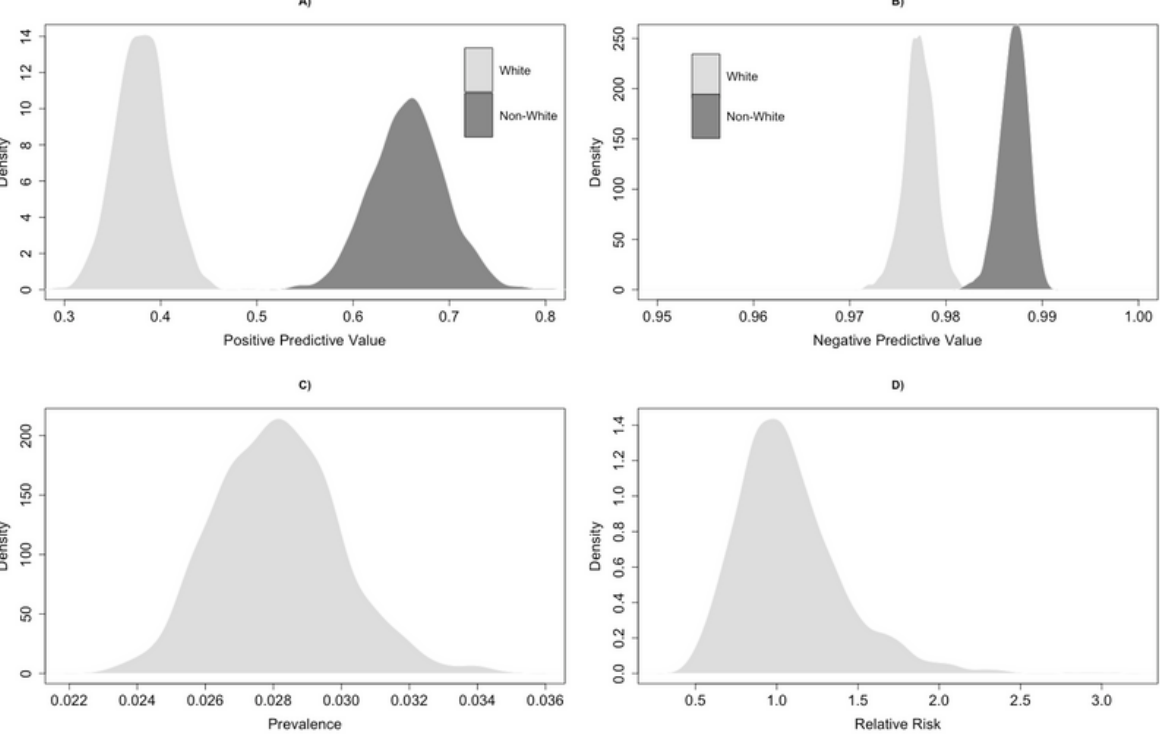
Figure 4 . Density plots depicting the distribution of simulated positive predictive value (A), negative predictive value (B), true prevalence (C), and relative risk (D) obtained during the quantitative bias analysis of differential outcome